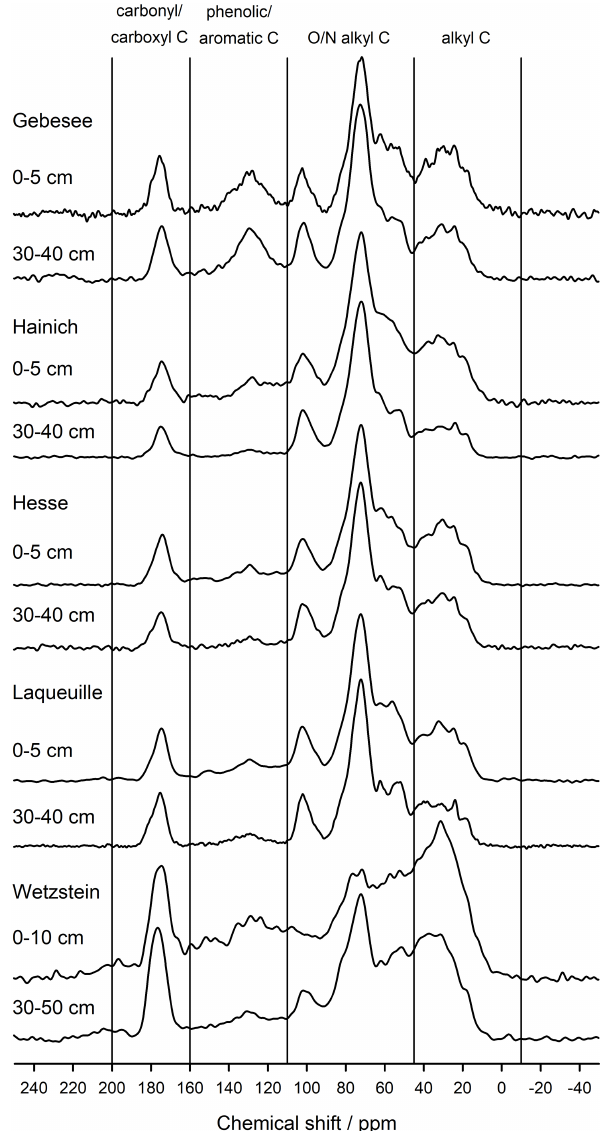
Figure 6. CPMAS- 13 C-NMR spectra of OM extracted into NaF– NaOH from the mineral-associated fraction of two soil depths from the five study sites: Gebesee (Chernozem, cropland), Hainich (Cam- bisol, beech), Hesse (Luvisol, beech), Laqueuille (Andosol, grass- land), and Wetzstein (Podzol, spruce).